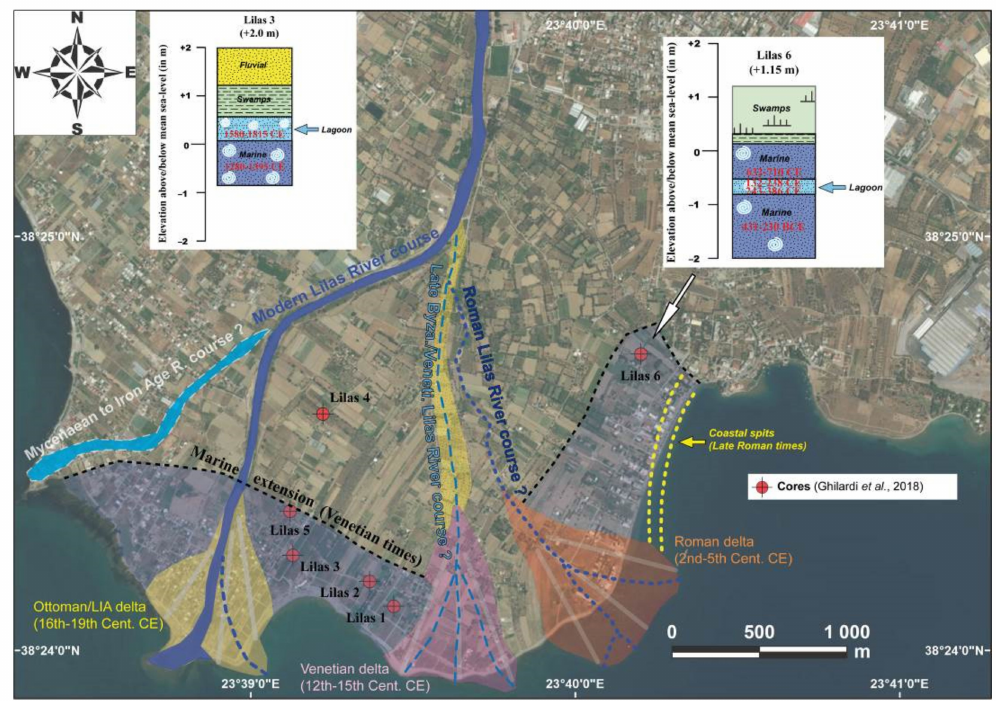
Figure 11. Palaeogeographical reconstructions of the Lilas river delta for the last three millennia (modified after